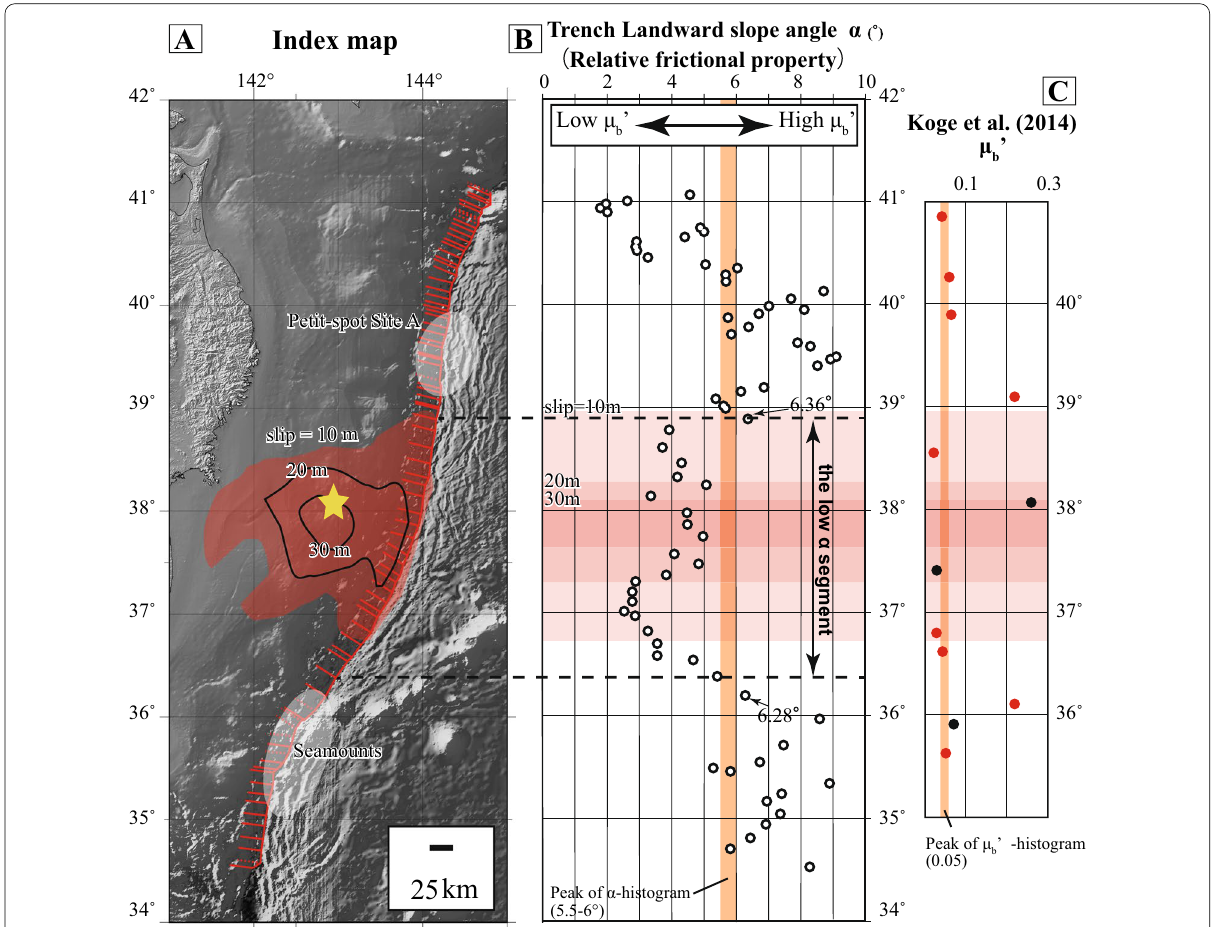
Fig. 5 Comparison of the spatial variation of slope angle α in the Japan Trench and the coseismic slip distribution. A Compiled coseismic slip along the Japan Trench (red contours). The epicenter of the Tohoku‑Oki earthquake is shown by a yellow star, and the red lines show the positions of bathymetric profiles used to obtain α . B Distribution of the slope angle α along the Japan Trench. The red area corresponds to the coseismic slip area in the map in A (Saito et al. 2011). The orange bar indicates the peak of the α distribution histogram. C North–south variation of the effective coefficient of basal friction from the seismic profiles (Koge et al. 2014). The red dots were determined by Tsuru et al. (2002) and the black dots were determined by Tsuji et al. (2011), and the JAMSTEC (Japan Agency for Marine‑Earth Science and Technology) crustal structural database